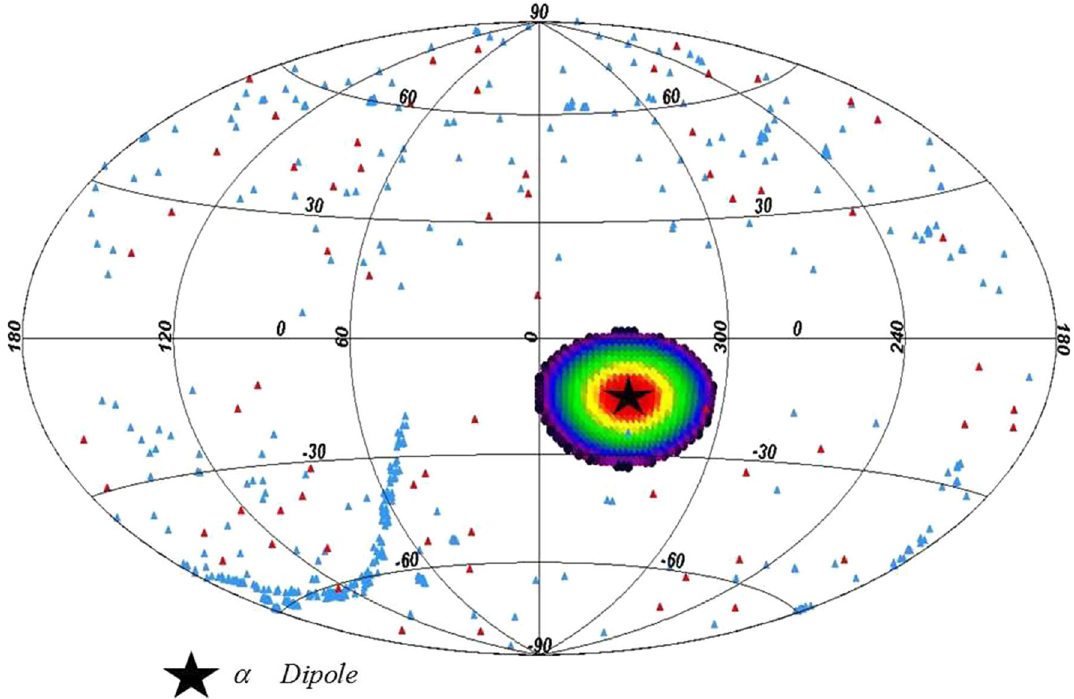
Fig. 5 The ( 1 − σ) error on dark energy dipole in Chameleon model, using Union2 + GRB data in the galactic coordinate system compared with best-fitting α -dipole (star). Blue and red triangles denote Union 2 and GRB data respectively